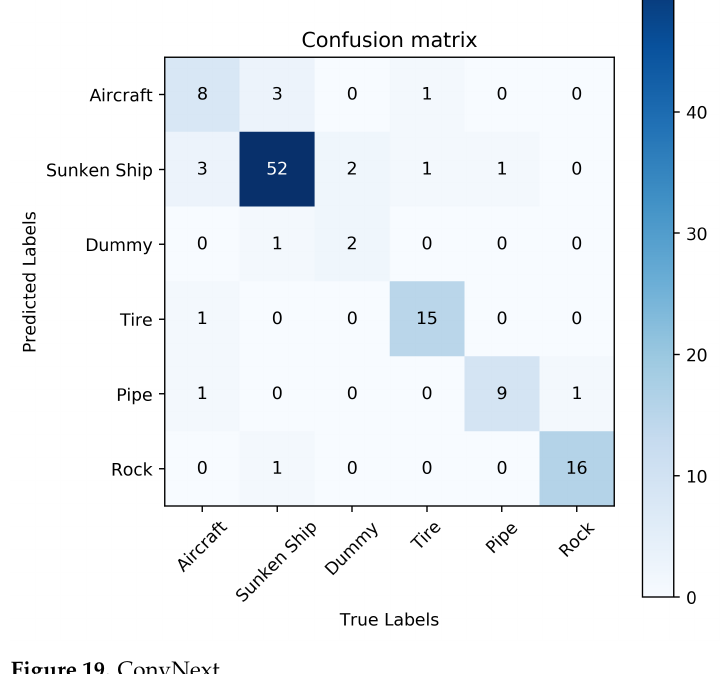
Figure 19. ConvNext.